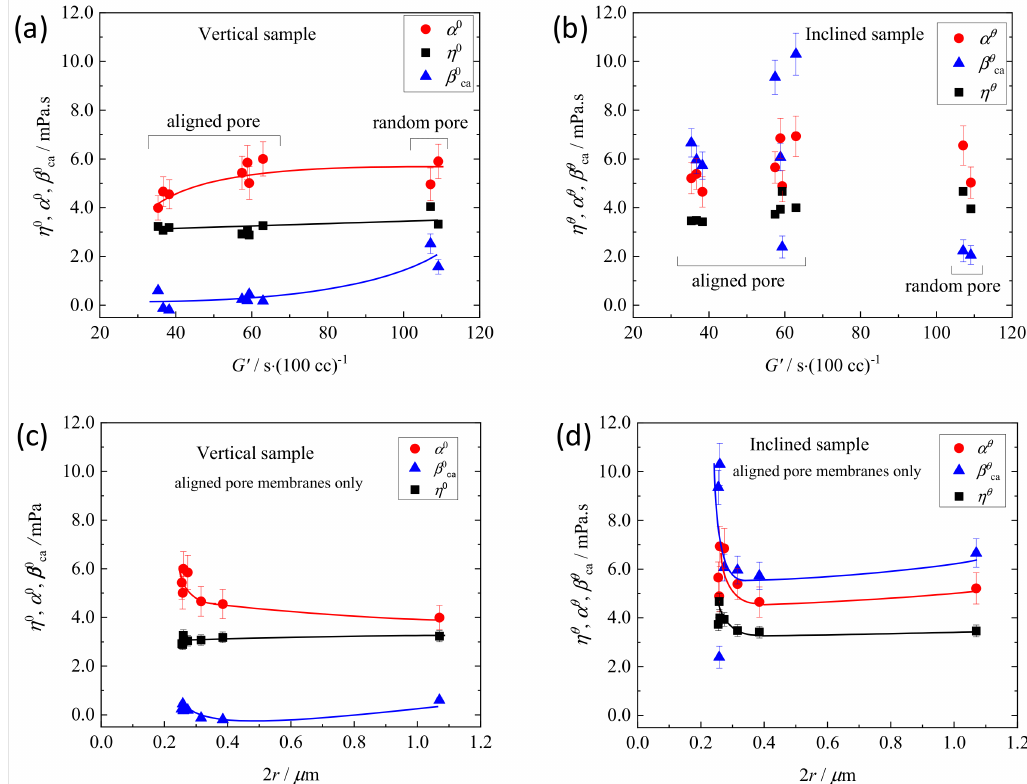
Figure 10. Estimated microviscosities, η , α , and β ca of L1 solution in ( a , c ) vertical PP membranes and ( b , d ) inclined PP membranes as functions of ( a , b ) G (cid:48) and ( c , d ) 2 r . Reprinted with permission from [37]. Copyright 2019 ACS